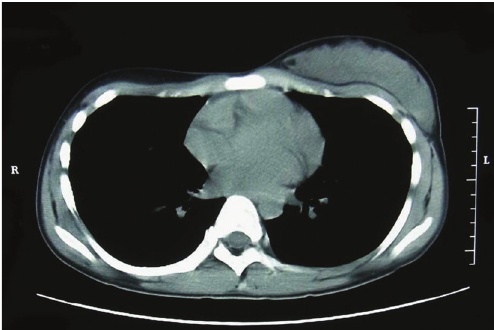
Figure 7: MRI: thorax and pectoralis major are symmetric. Normal mammary gland is present on the unaffected